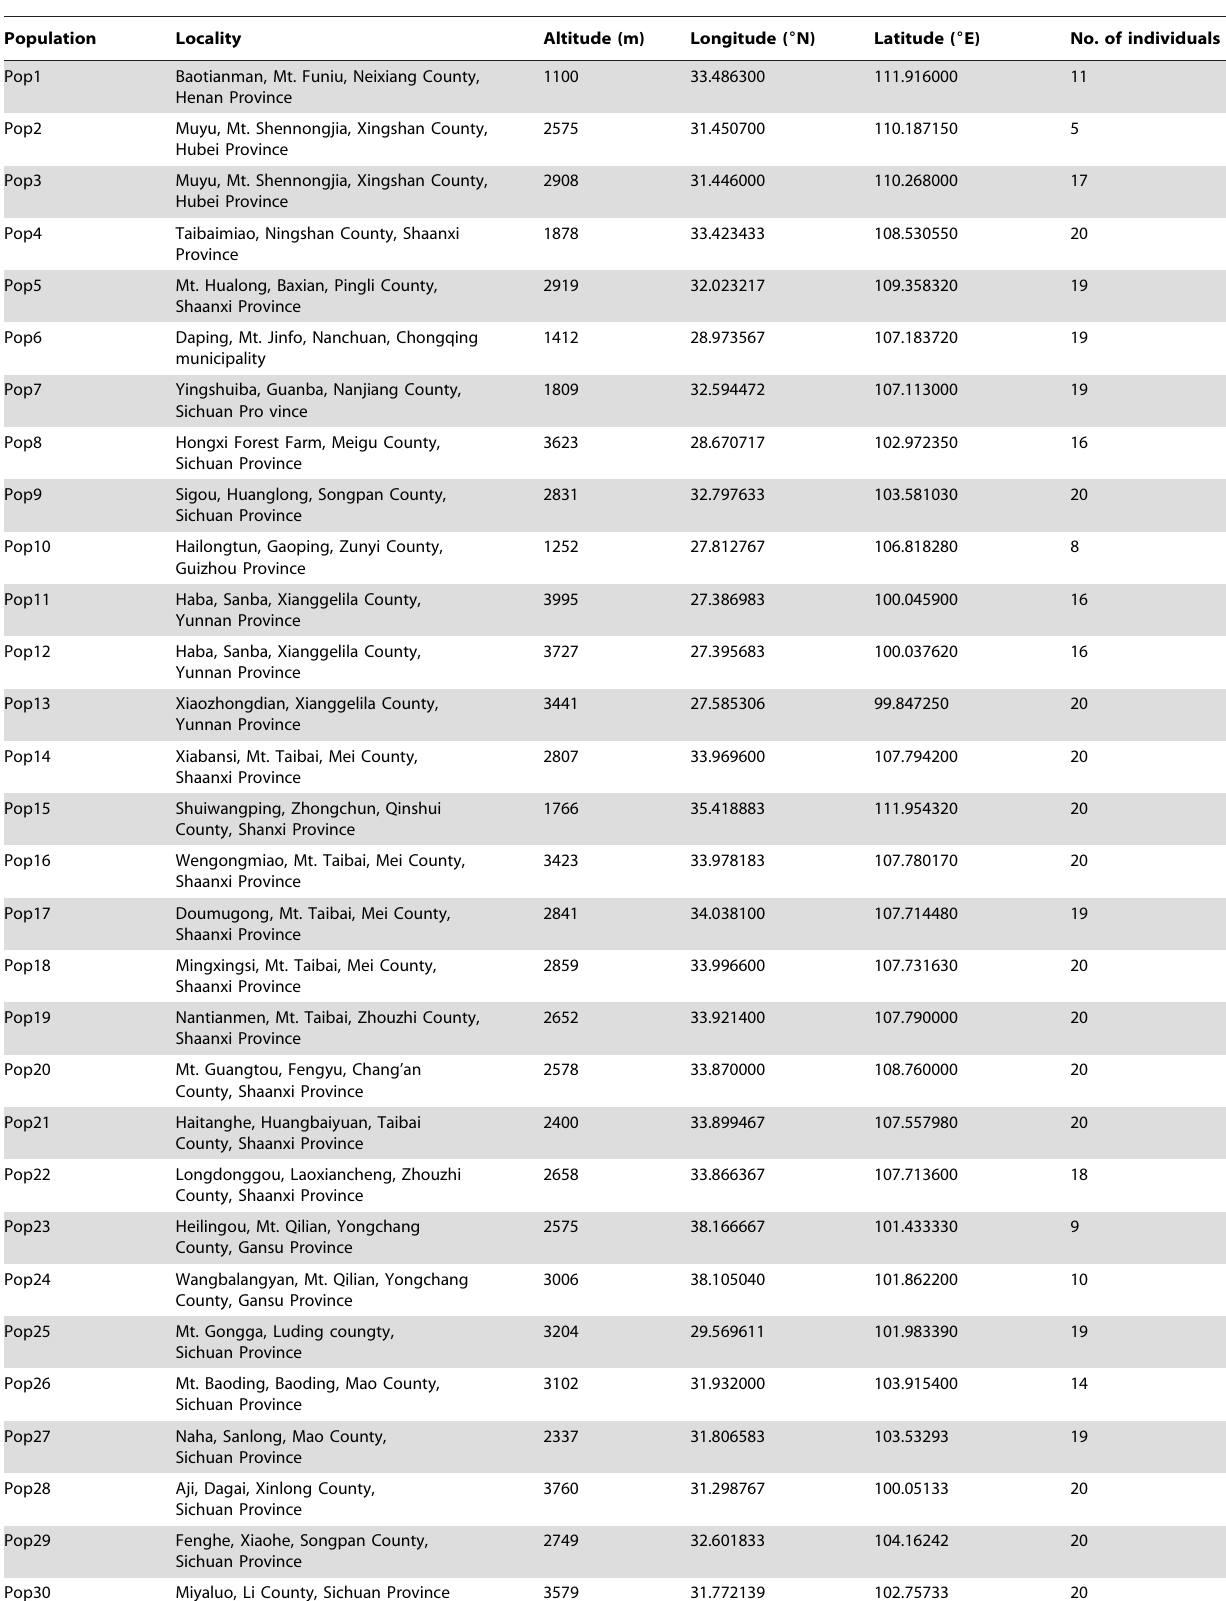
Table 1. Studied population information of R. palmatum complex.